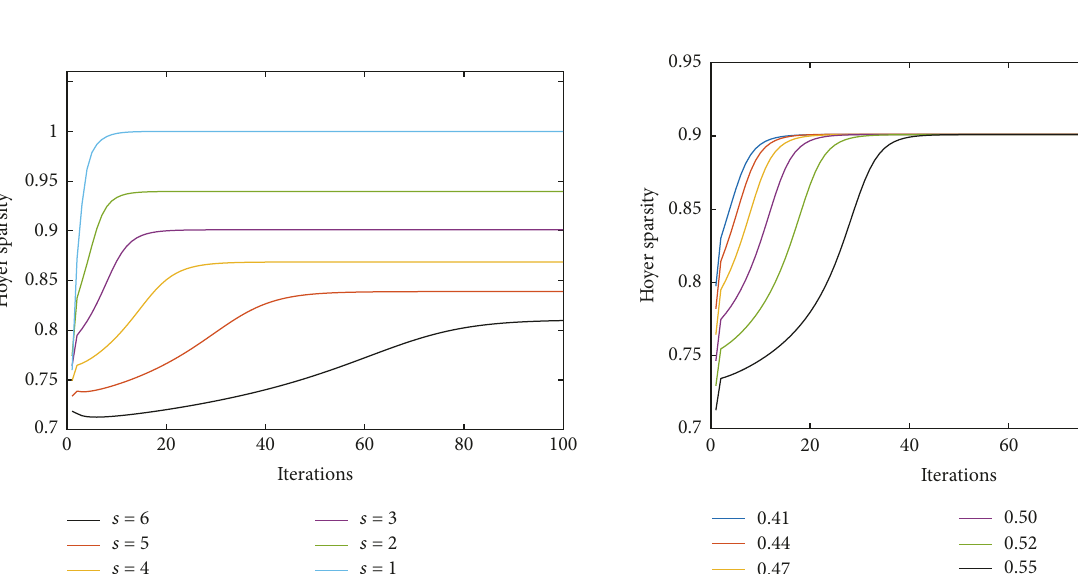
Figure 5: The recovery curves.